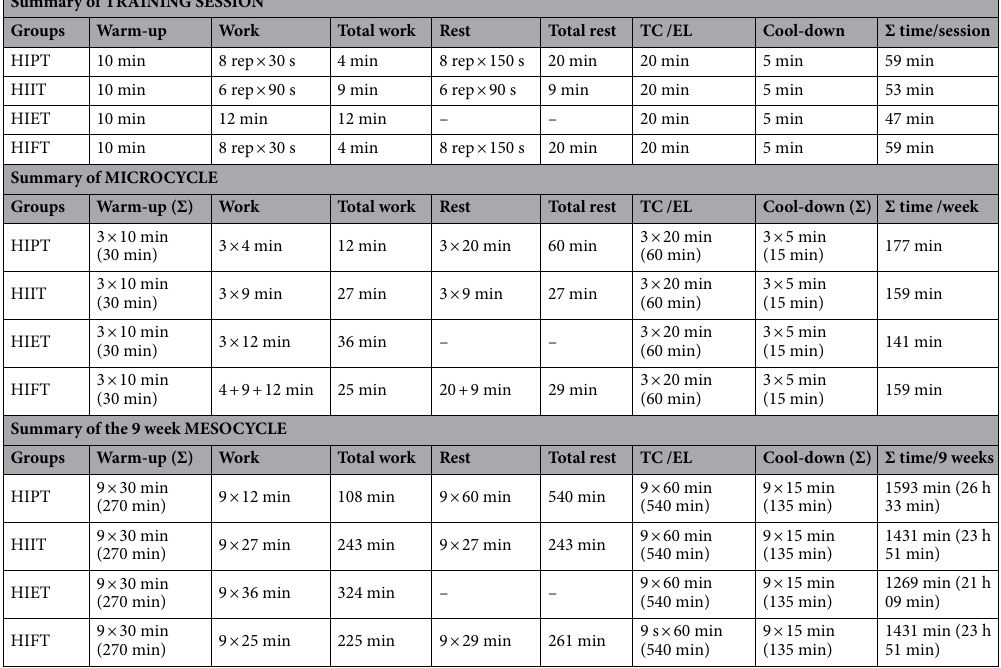
Table 9. General overview of training regimen. TC/LC—technique correction and learning of the exercises performed.